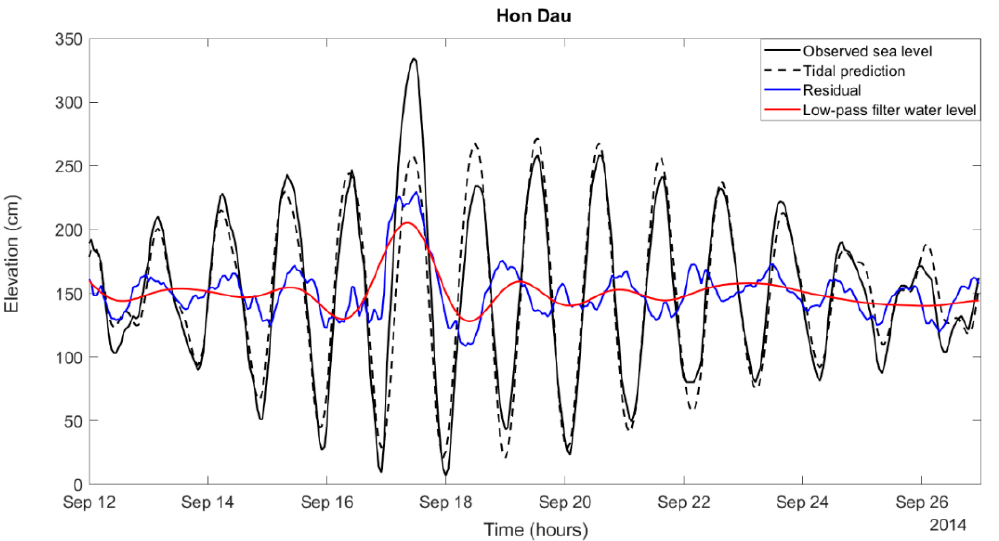
Figure 4. Combination between tidal analysis and low-pass filter at Hon Dau station in Typhoon Kalmaegi (September 2014).